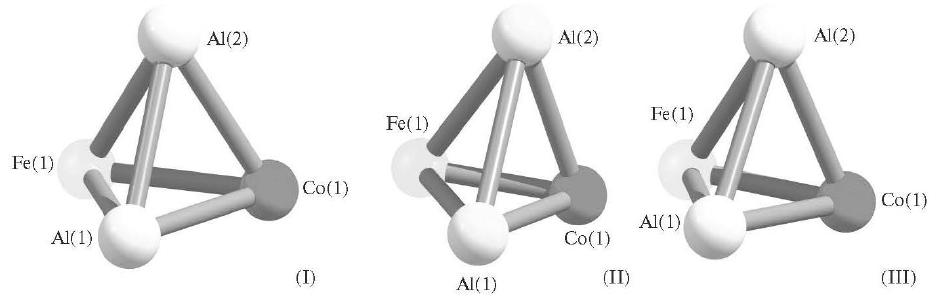
Figure 3. Molecular structures of three Al 2 FeCo isomers: ( I )—with most high energy, ( III ) —with most low energy and ( II )—with intermediate energy between ( I ) and ( III ) [79].